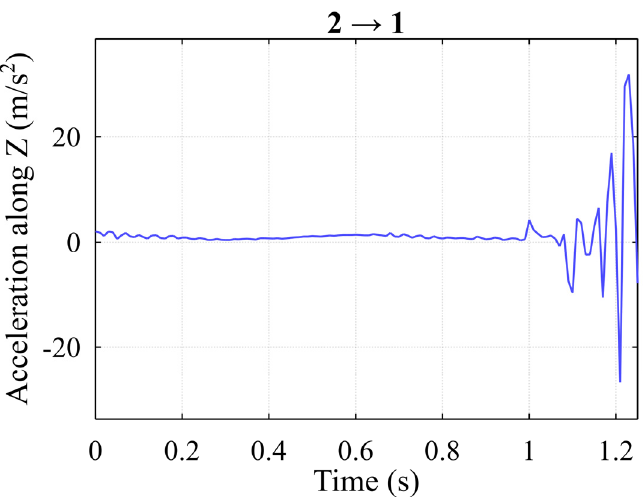
Figure 12. Shock moments along the Z-axis during movement in the hull of the ship.